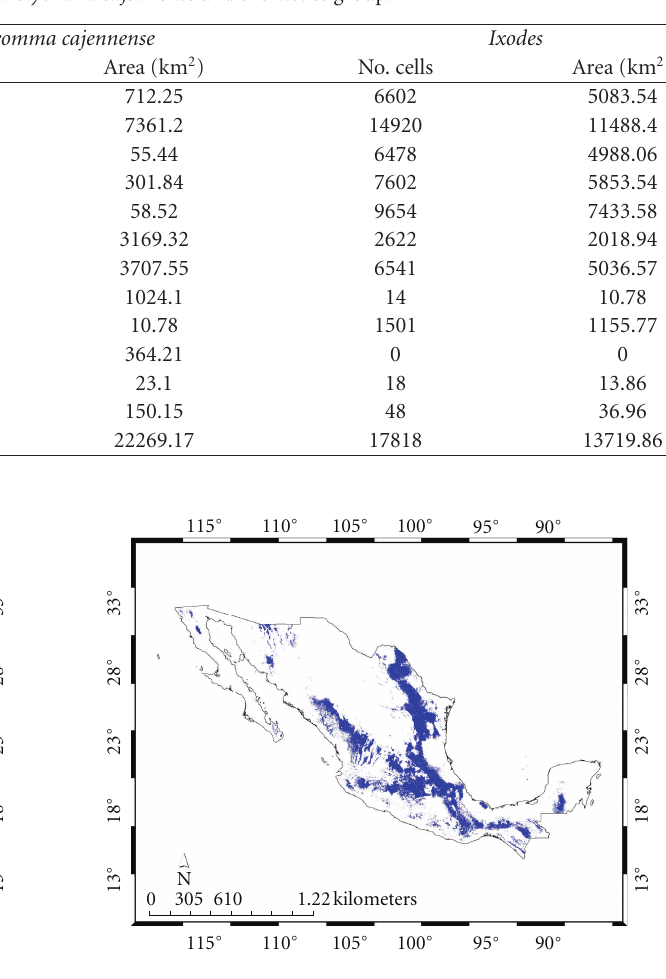
Table 6: Vegetation types for Amblyomma cajennense and the Ixodes group.